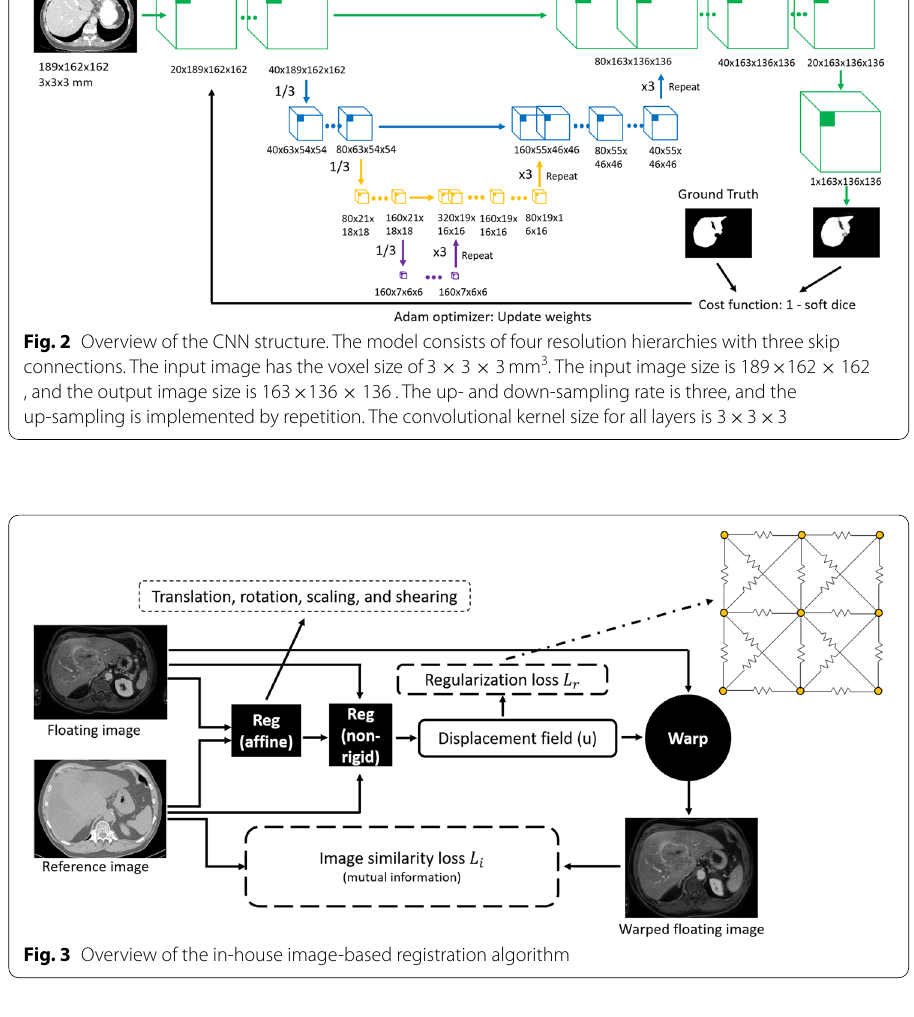
Fig. 3 Overview of the in-house image-based registration